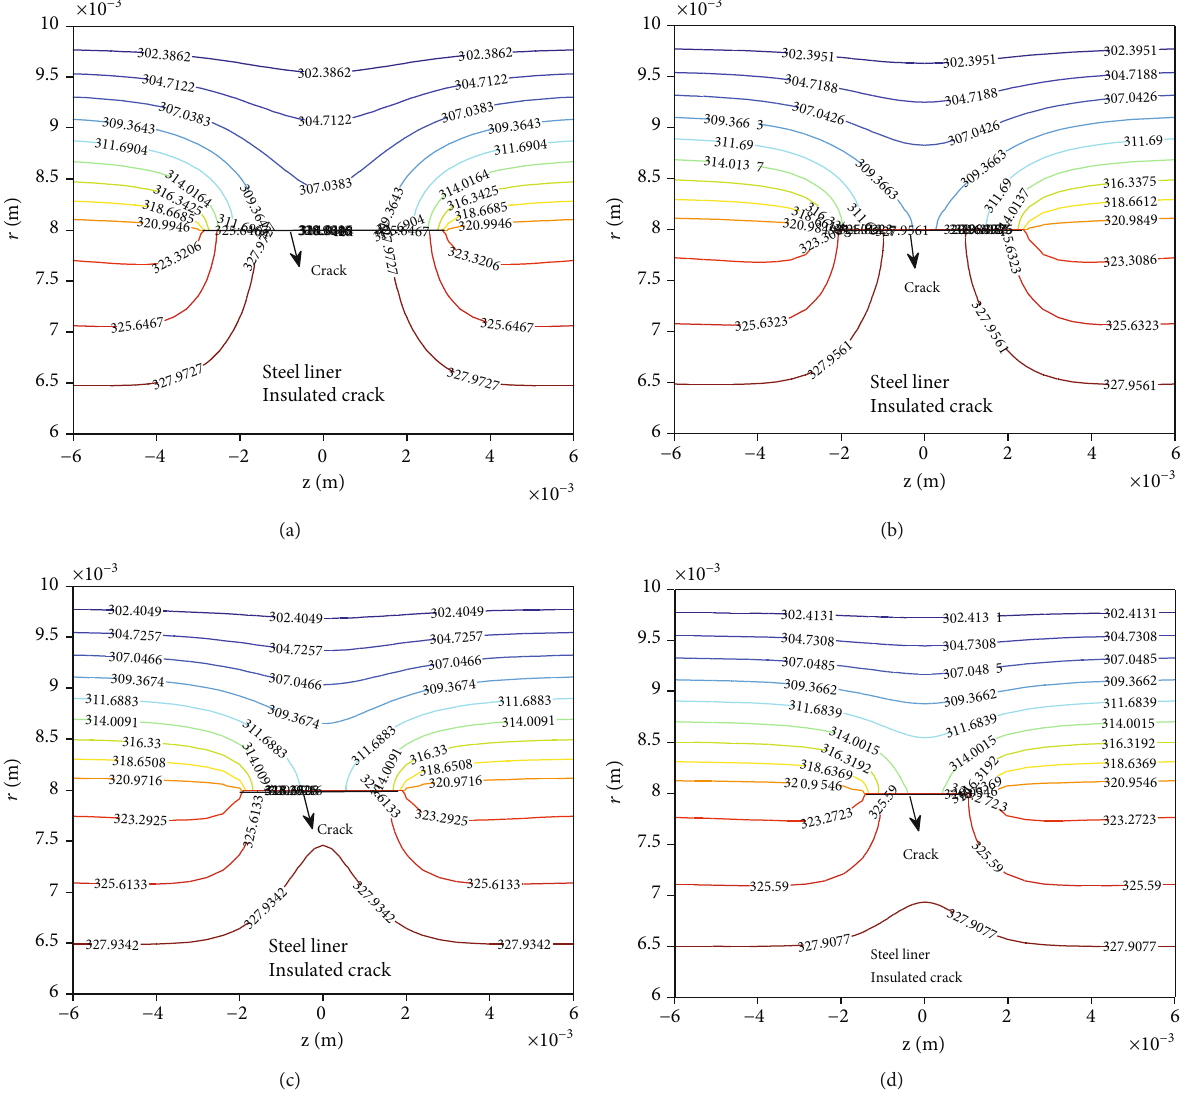
Figure 10: E ff ect of crack length on the 2D temperature distribution around the crack: (a) c = 0 : 003 m, (b) c = 0 : 0025 m, (c) c = 0 : 002 m, and (d) c = 0 : 0015